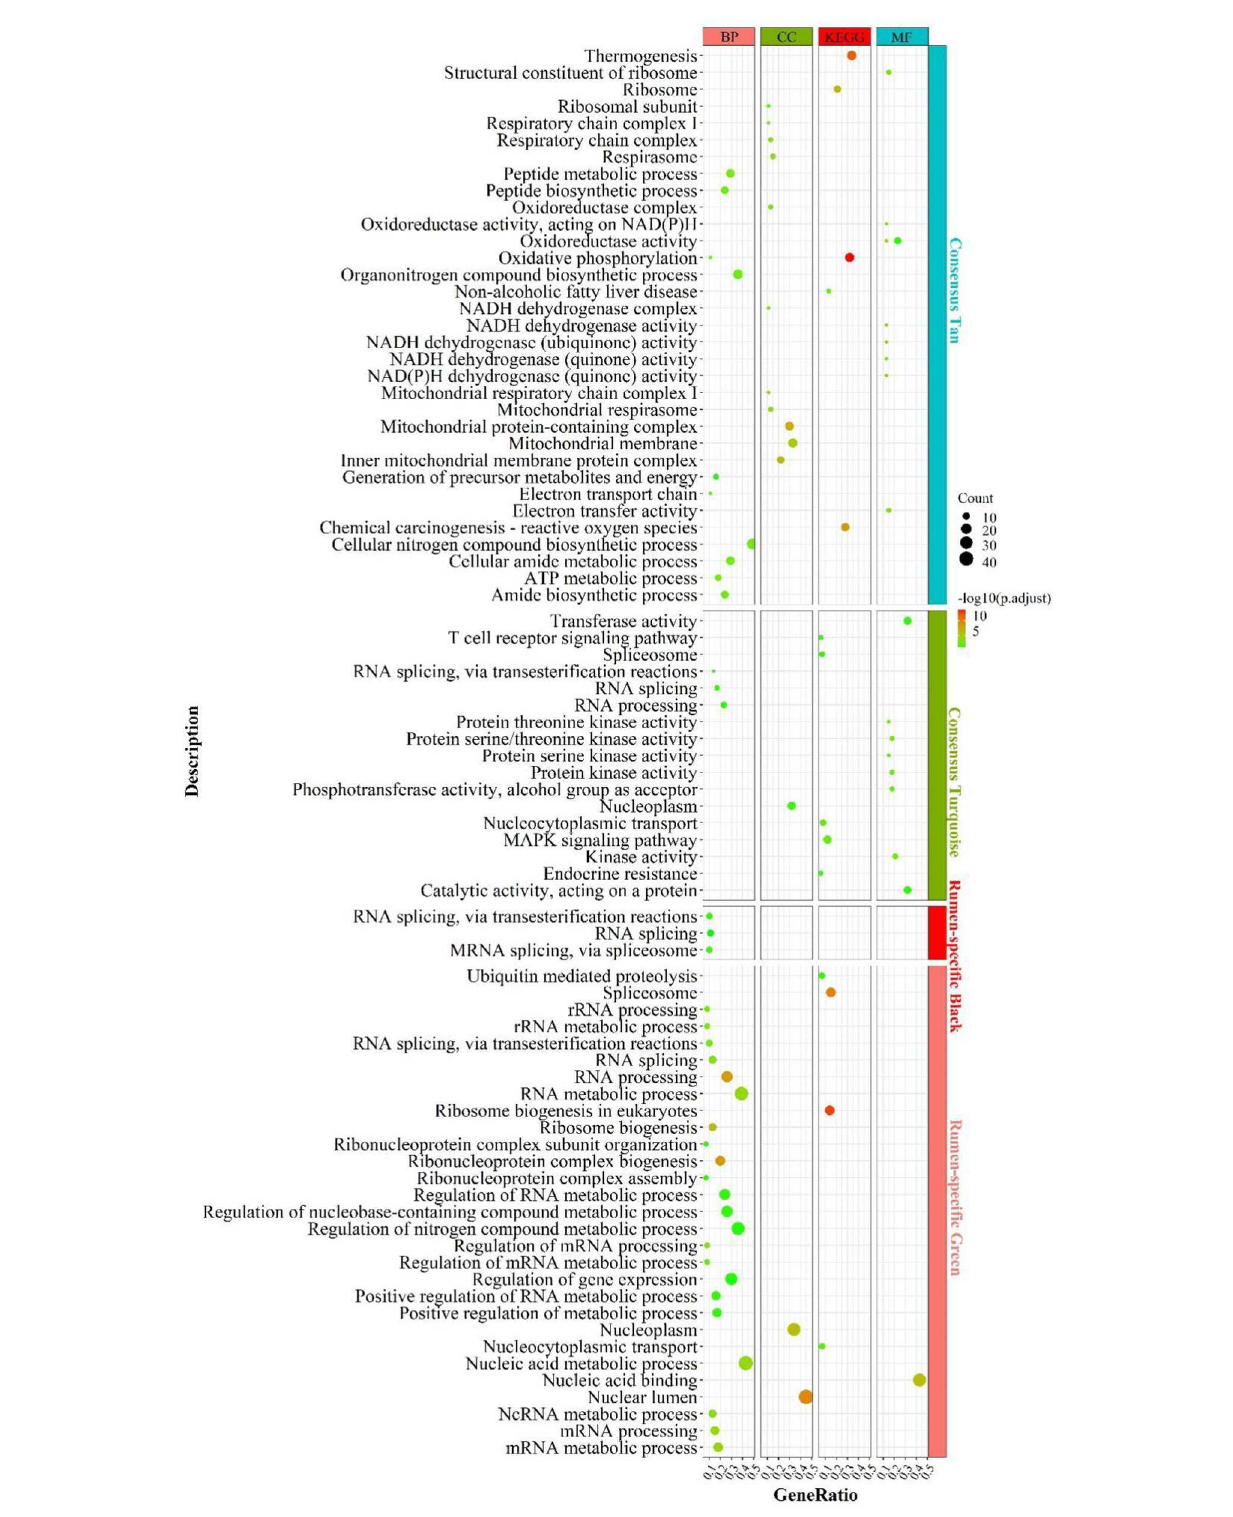
FIGURE2 Enrichment analysis for consensus or rumen-/liver-specific modules in RL regulatory axis. The dot size and color represented enriched gene numbers and the enriched significance.